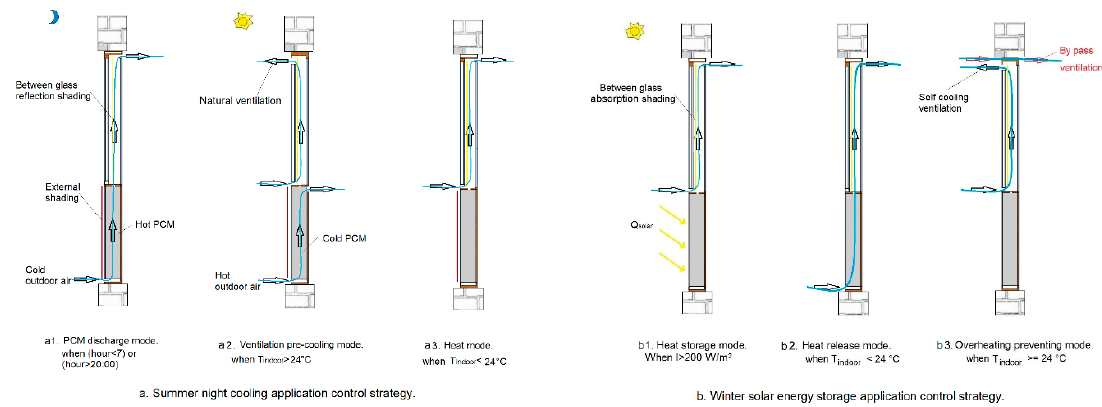
Figure 5. The PCM-enhanced ventilated windows (PCMVW) control strategies for both summer and winter applications [45].